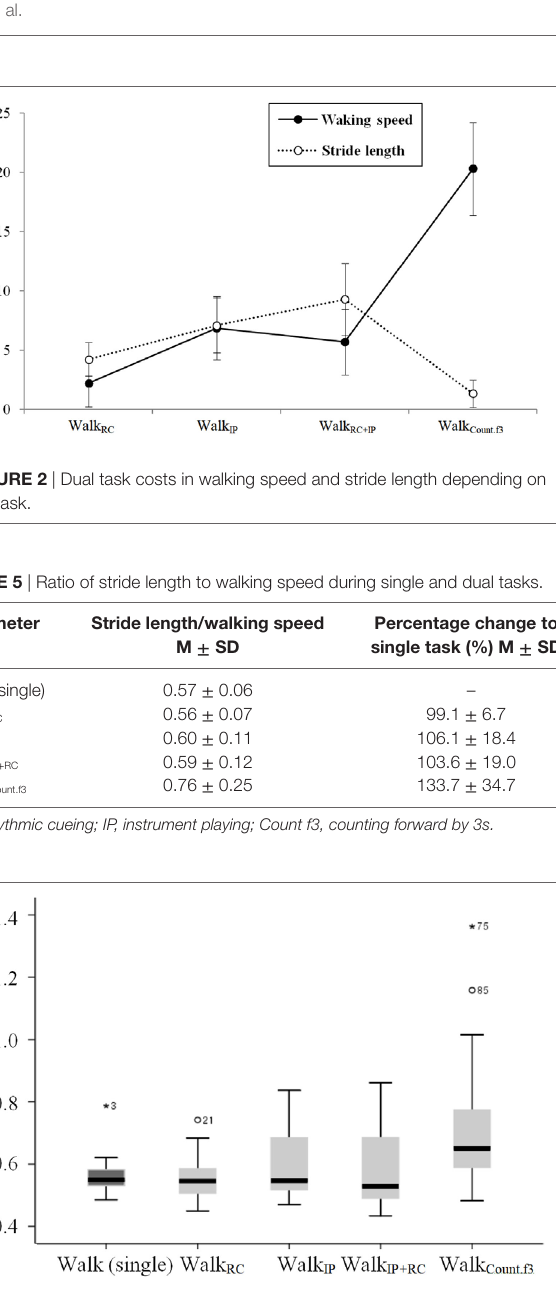
FigUre 3 | Ratio of stride length to walking speed depending on the task.